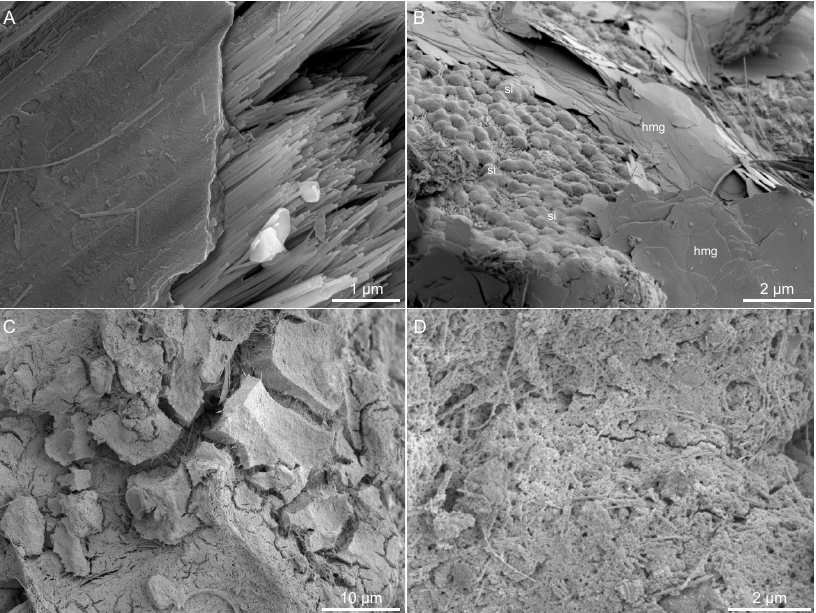
Figure 4. Electron micrographs depicting the various morphologies of silica in the Bio-plot. ( A ) A layer of amorphous silica formed through incongruent dissolution of chrysotile from 2–4 cm depth in the Bio-plot. Note, left side of micrograph: silica, right side of micrograph: chrysotile. ( B ) Botryoidal silica precipitated on the surface of serpentinite grains in the Bio-plot at a depth of 2–4 cm. ( C ) Desiccated crust of amorphous silica sampled from the 2-cm deep pyroaurite horizon in the Bio-plot, containing chrysotile fibers ( D ). Note: hmg: hydromagnesite, si: silica. Minerals 2017 , 7 , 191